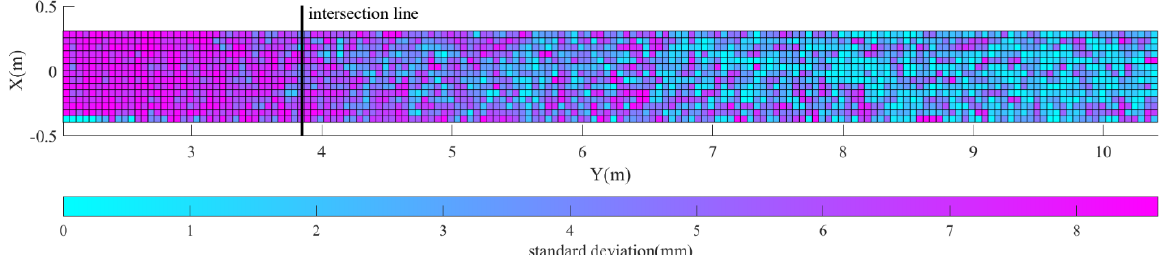
Figure 9. Raster image for Slope 1 colored by the standard deviation per pixel. A pixel standard deviation is obtained by computing the standard deviation of all Z values in the